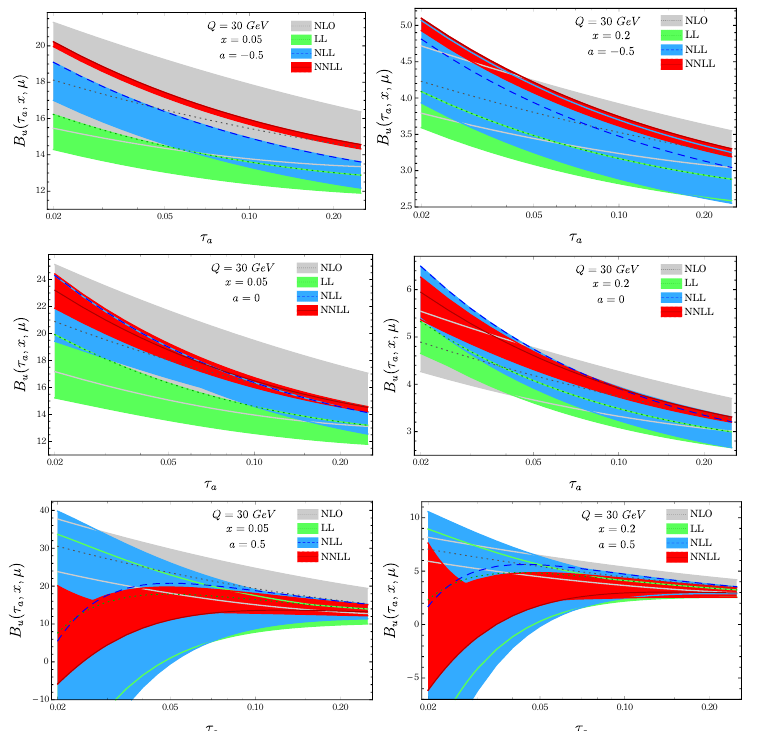
Figure 1 . τ a variation of beam function B u ( τ a , x, µ ) for u quark at Q = 30 GeV. Two columns are for x = 0 . 05 , 0 . 2 and three rows are for a = − 0 . 5 , 0 , 0 . 5